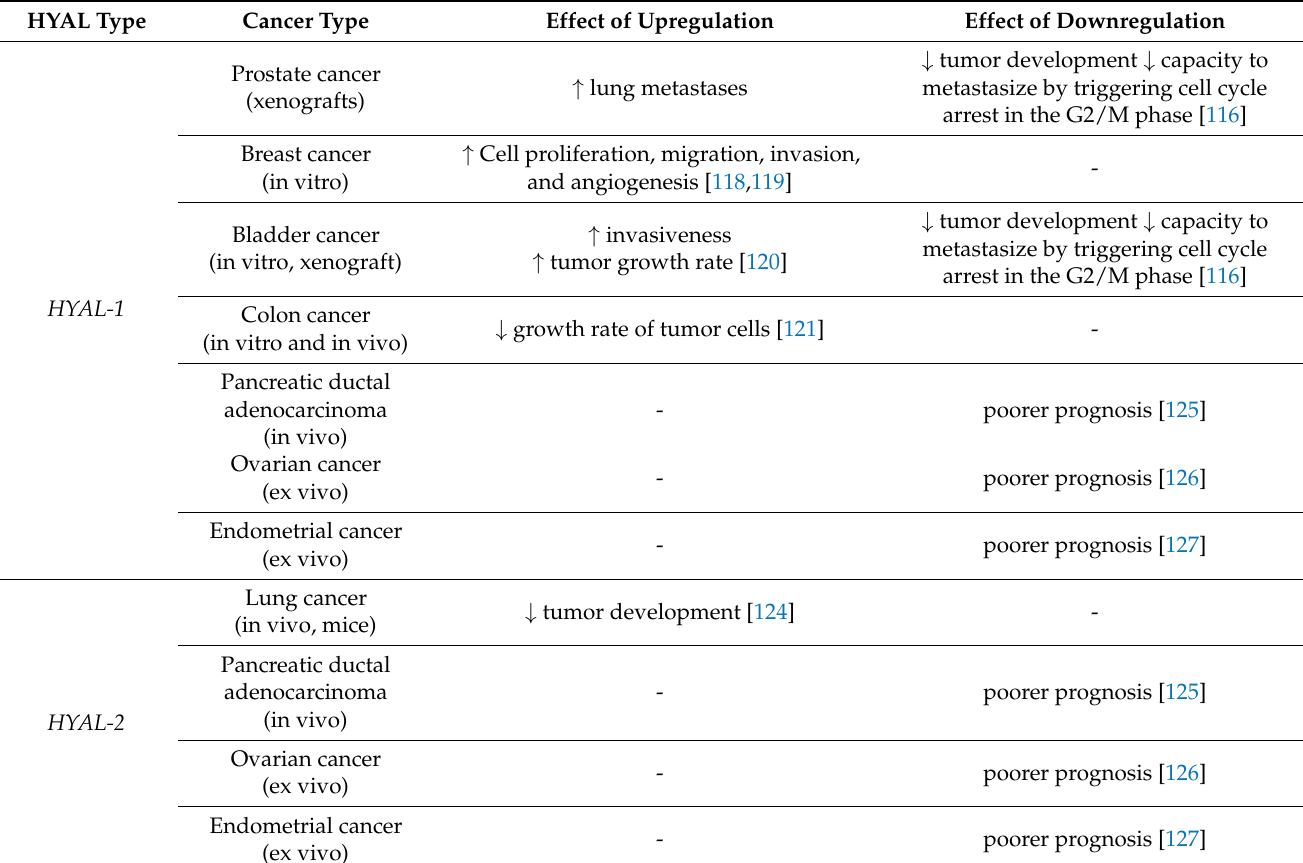
Table 2. HYAL expression-dependent effects on cancer